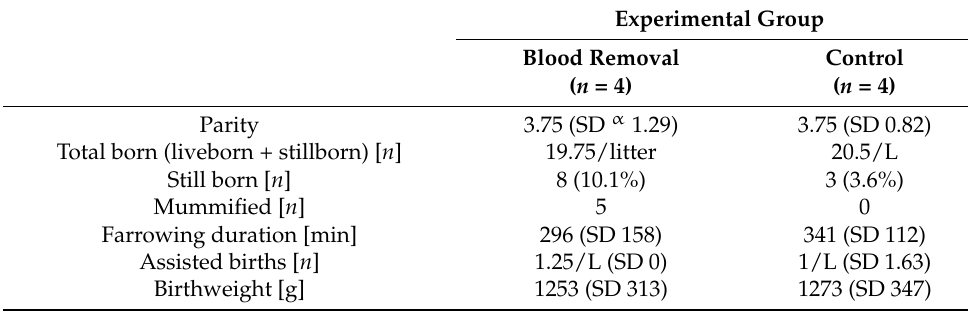
Table 7. Clinical outcomes at farrowing in trial I.